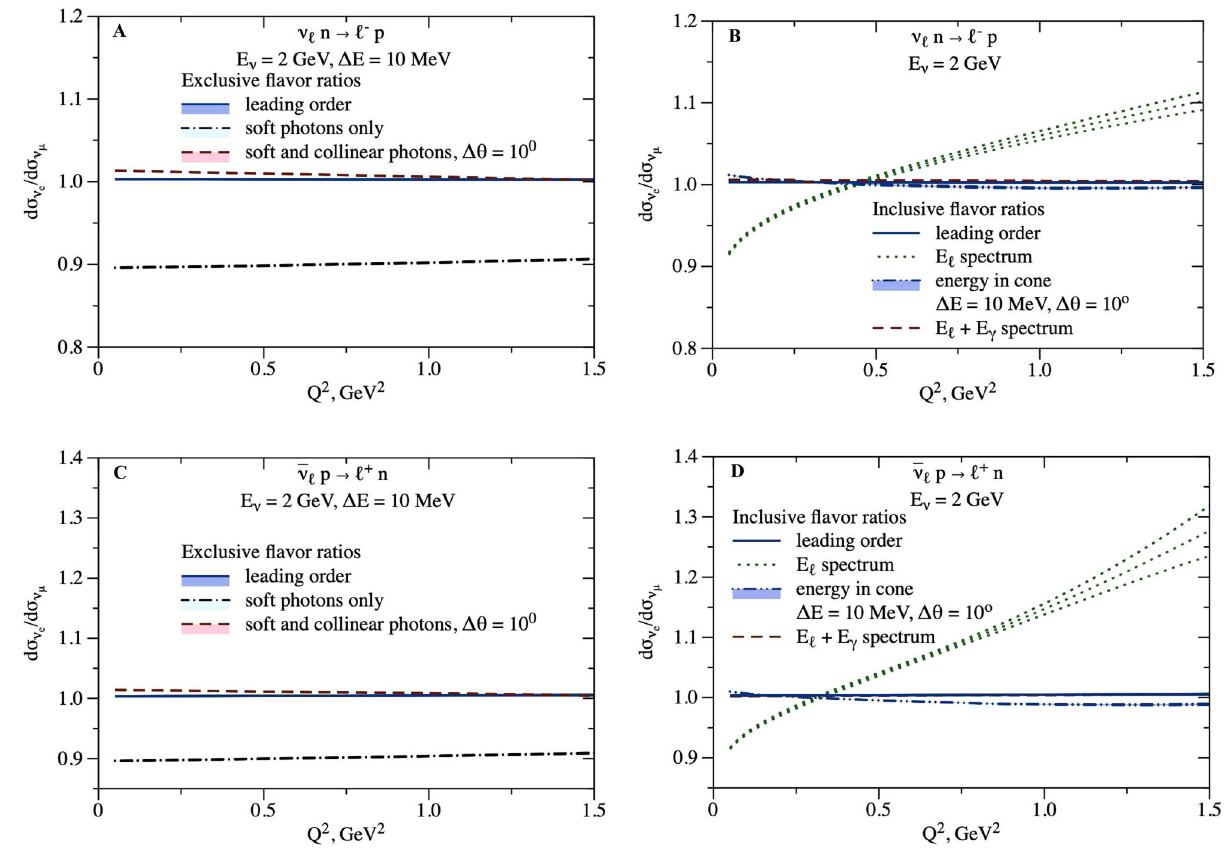
Fig. 2 | Radiatively corrected ratio of ν e versus ν μ cross sections. Radiatively corrected ratio of ν e versus ν μ cross sections and corresponding uncertainty for exclusive observables ( A , C ) and inclusive observables ( B , D ). A , B : Neutrino scat- tering. C , D : Antineutrino scattering. For exclusive observables, the ratio of cross sectionswithsoftphotonsofenergybelow Δ E =10MeVisrepresentedbytheblack dash-dotted lines. The tree-level ratio is shown by the blue solid lines. The red dashed lines with a legend "soft and collinear photons" represent the ratio of jet